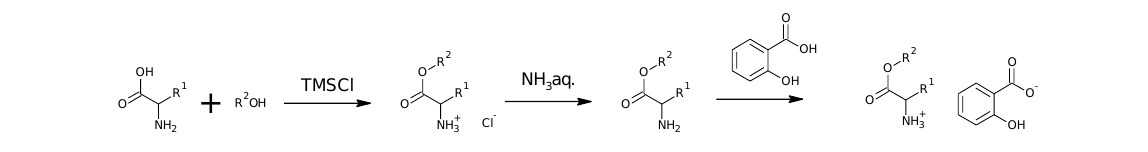
Scheme 1. General synthetic procedure for amino acid alkyl ester salicylate, [AAOR][SA].